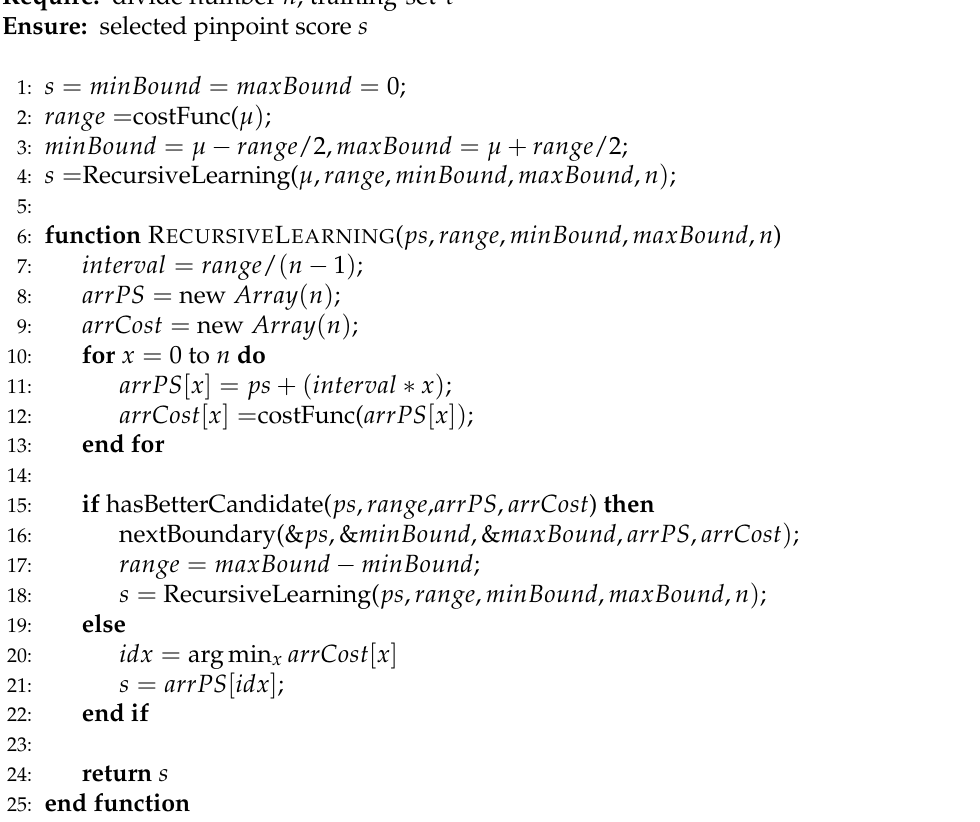
Algorithm 1 Bias-Based Predictor’s (BBP’s) recursive learning of pinpoint score s